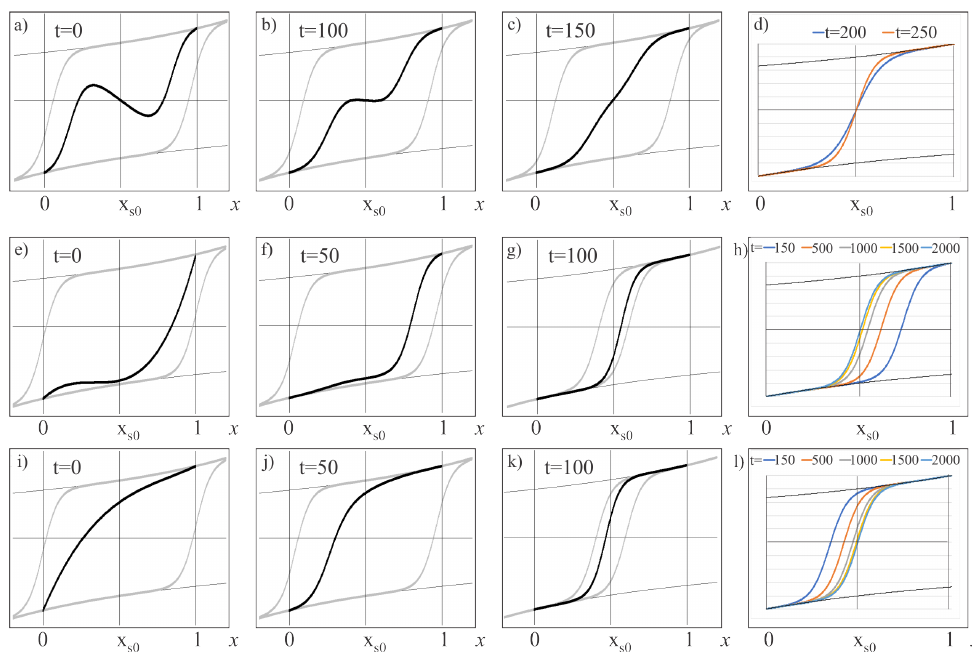
Figure 2. the numerical solution of problems ((52) I) ( a – c ); ((52) II) ( e – g ); ((52) III) ( i – k ) at various moments of time (solid black bold line) and location of the upper and lower solutions (solid gray bold lines); the illustration of the stabilization over time of the solution to problem ((52) I) ( d ); ((52) II) ( h ); ((52) III) ( l ). Thin thin black curves denote the reduced equation solutions ϕ ( − ) = − ( x + 2 ) − 1 and ϕ (+) = − ( x − 3 ) − 1